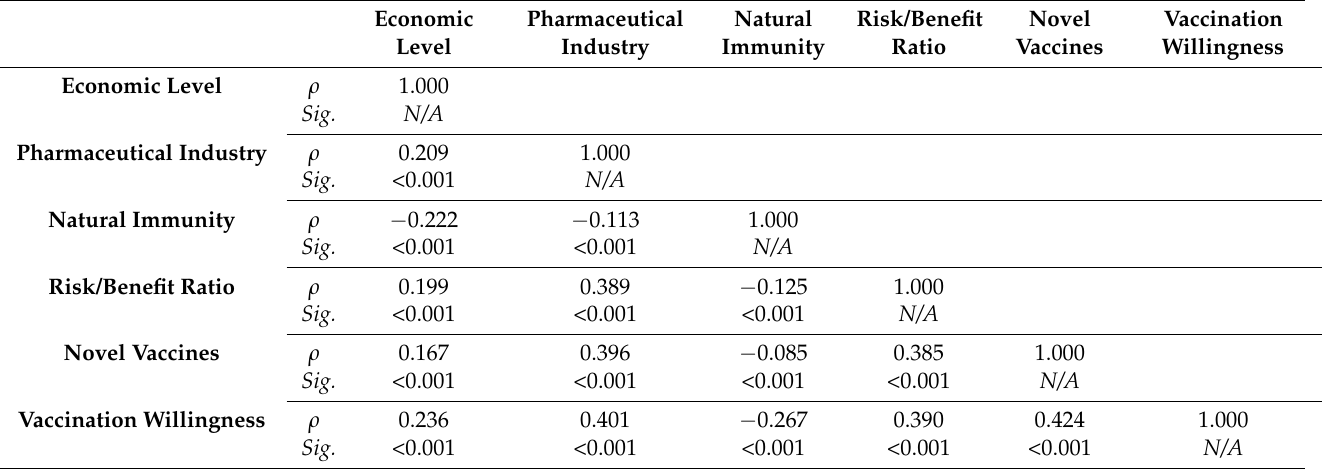
Table 4. Bivariate correlation among COVID-19 vaccine willingness and its suggested predictors, February 2021 ( n = 6639).